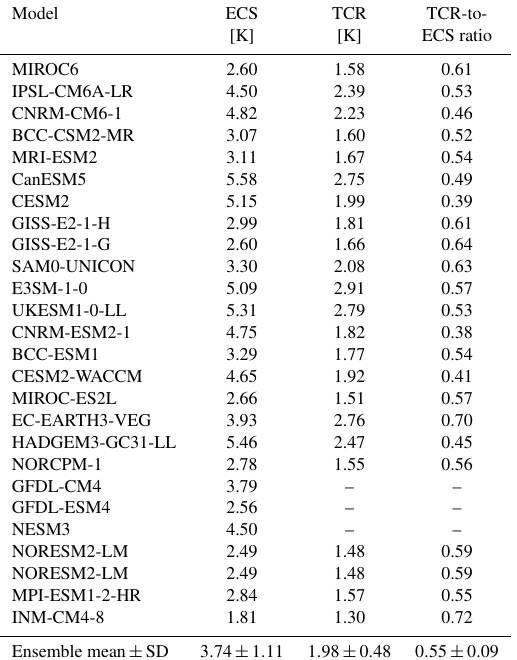
Table A1. List of CMIP6 models and model climate parameters.